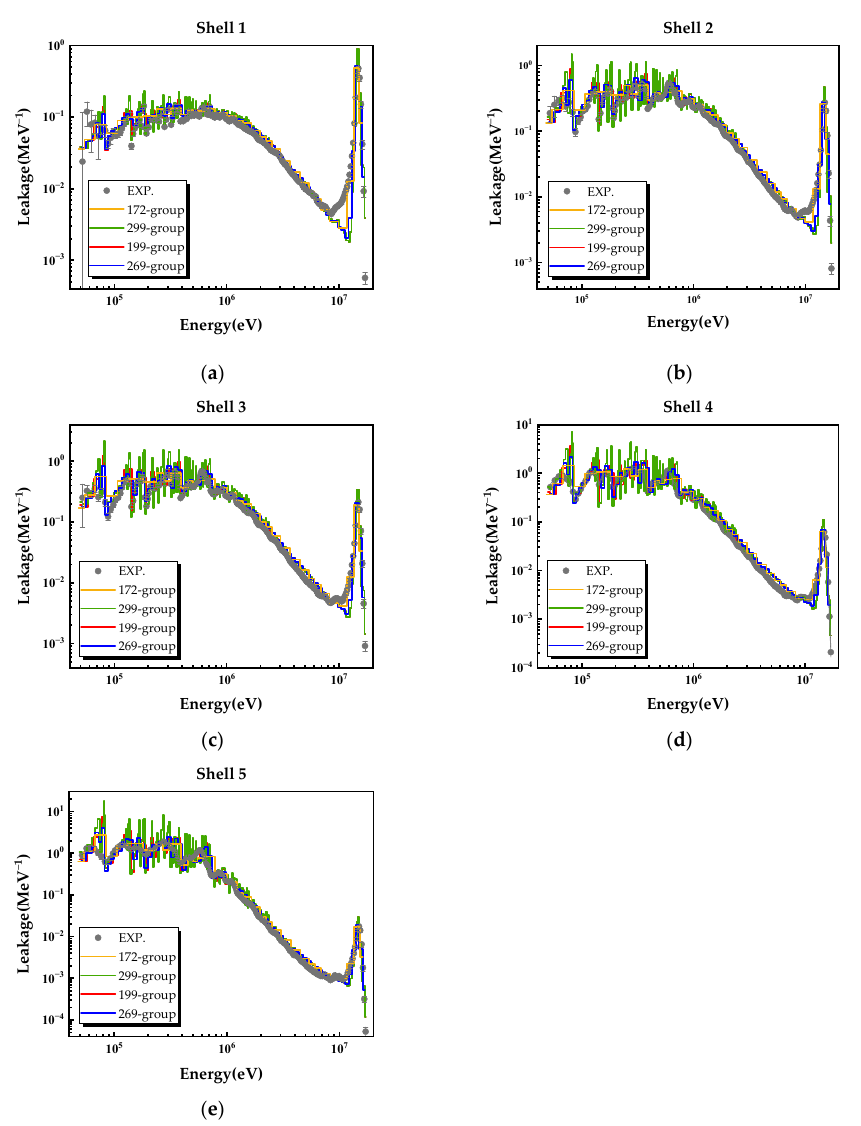
Figure 9. DT source neutron leakage spectra of iron spheres with five different outer radii and thicknesses. ( a ) Shell 1: radius 4.5 cm, thickness 2.5 cm. ( b ) Shell 2: radius 12 cm, thickness 7.5 cm. ( c ) Shell 3: radius 12 cm, thickness 10 cm. ( d ) Shell 4: radius 20 cm, thickness 18.1 cm. ( e ) Shell 5: radius 30 cm, thickness 28 cm.